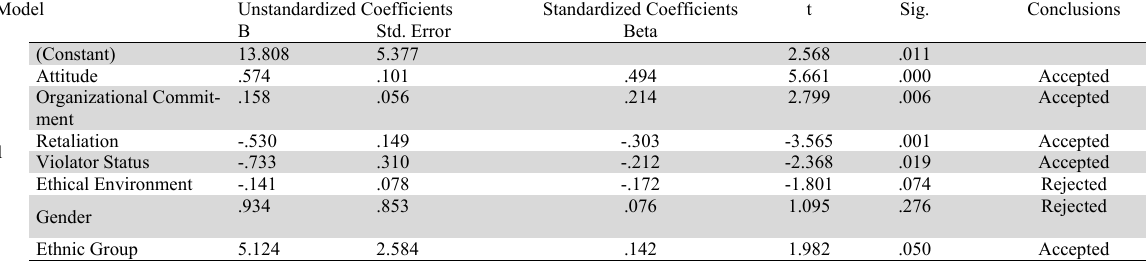
The Results of Multiple Linear Regression Test